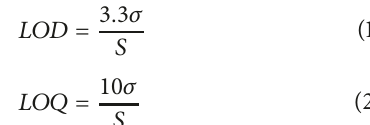
of nitrate was constructed. Linear equation, coefficient of determination (R 2 ), and test range were